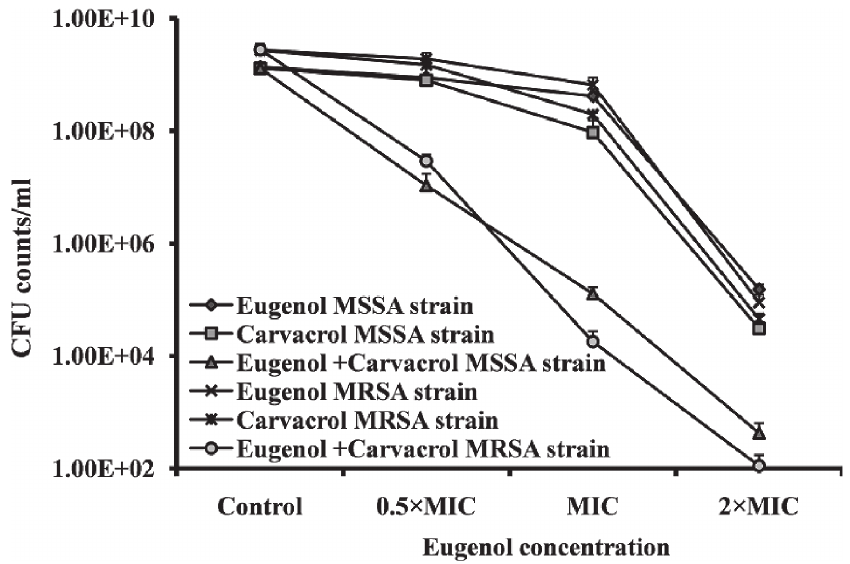
Fig 8. Synergistic effect of eugenol with carvacrol for eradication of preformed biofilm. The MRSA and MSSA pre-established biofilms were treated with different concentrations of eugenol or carvacrol alone or in combination, and the cell viability was determined by cfu counts. The experiment was performed in triplicates and repeated two times.